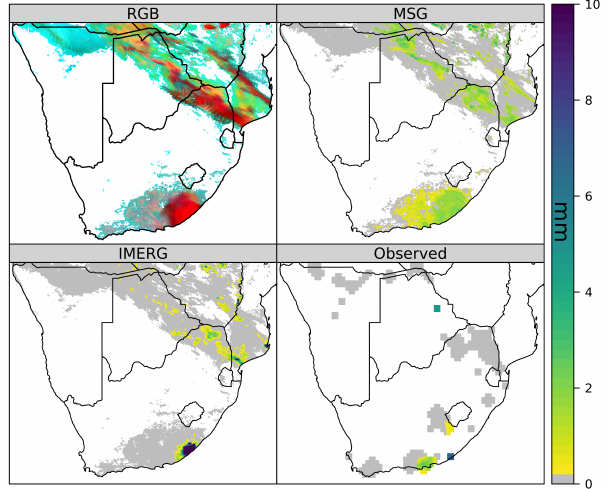
Figure 10. Sample satellite scene from 24 April 2014 10:00UTC represented as a VIS0.8-IR3.9-IR10.8 false-colour composite ac- cording to (Rosenfeld and Lensky, 1998) in which cloud optical depth is indicated by red colouration, cloud particle sizes and phases in green and the brightness temperature modulates in blue. The rain- fall estimates for this scene (estimated using the daytime model) are shown as well as the corresponding GPM IMERG product. Ob- served rainfall is depicted where weather station data were avail- able. For visualisation purposes, the spatial extent of the stations was increased. White background in the colour composite as well as in the MSG-based retrieval and the GPM IMERG product represent no data due to missing clouds. In addition, the white background in the representation of the observed rainfall is due to the absence of weather